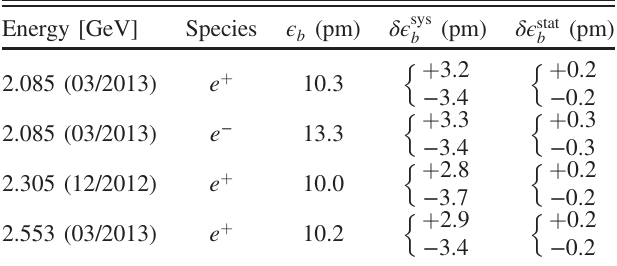
TABLE III. Lowest-achieved vertical emittance at CesrTA in a variety of energies. Electron conditions are only reported for the April 2013 CesrTA run at 2.085 GeV. Energy